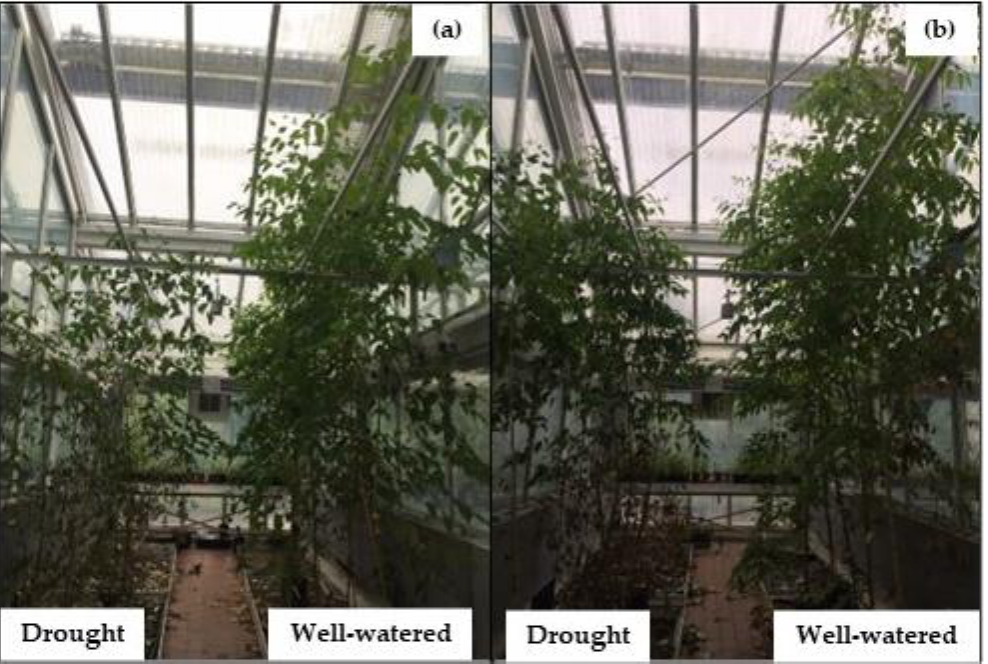
Figure 4. Eucalyptus grandis experimental plants grown at ( a ) ambient CO 2 and ( b ) elevated CO 2 ; with daily irrigation (well-watered) and cyclic drought (drought). The photograph was taken at the end of the experimental period.